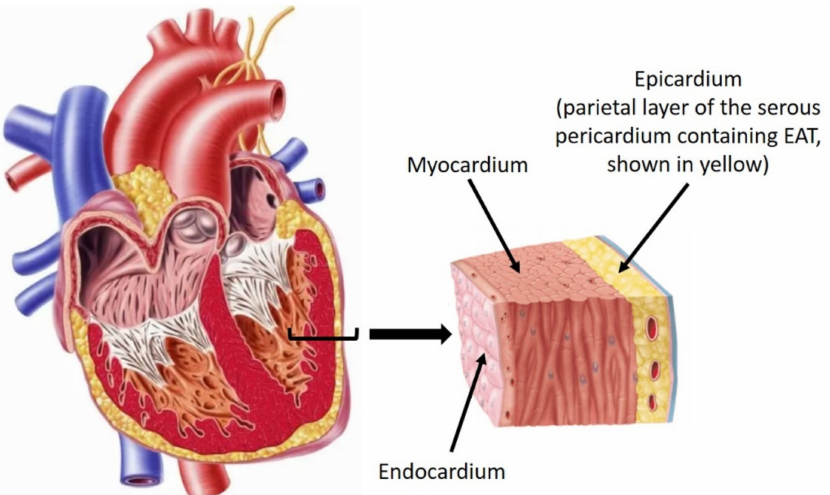
Figure 1. Layers of tissue surrounding the heart. EAT is situated deep in the pericardial fat, between the layers of visceral pericardium and myocardium. Pericardial fat is situated between the visceral and parietal pericardium. Paracardial fat is the general term referring to fat associated with the heart. Adapted from Newman ( left ) [13] and Betts et al. ( right ) [14].